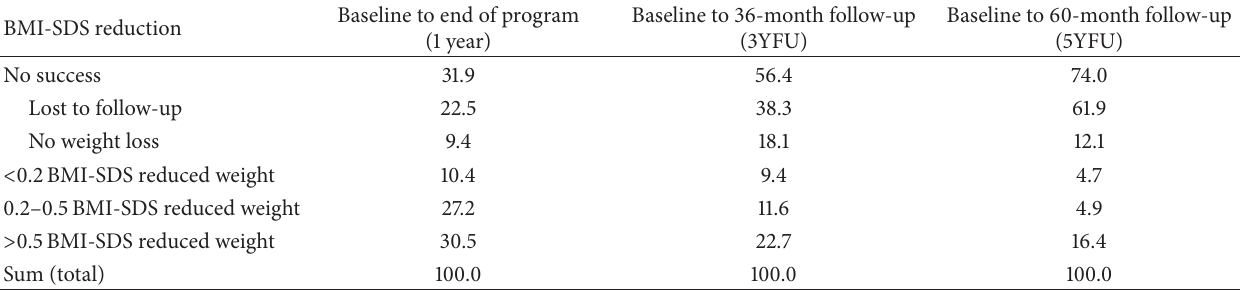
Table 2: Proportion (in %) of unsuccessful and successful weight reduction in the sample ( 𝑁 = 596